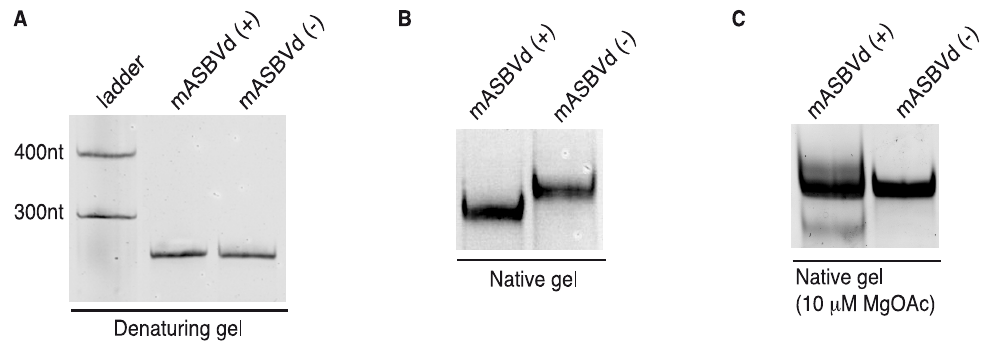
Figure 3. Electrophoretic mobility of mASBVd RNAs. The mASBVd (+) and mASBVd ( − ) transcripts were separated on 8% PAGE gels in 1× TBE buffer under denaturing ( A ) and native ( B ) conditions. The RiboRuler TM low range RNA ladder (Fermentas, Thermo Fisher Scientific Inc., Waltham, MA, USA) was loaded in parallel with mASBVd (+) and ( − ) into the denaturing gel (A). ( C ) RNA transcripts were analyzed on 8% PAGE native gel in 1× TB buffer containing 10  M magnesium